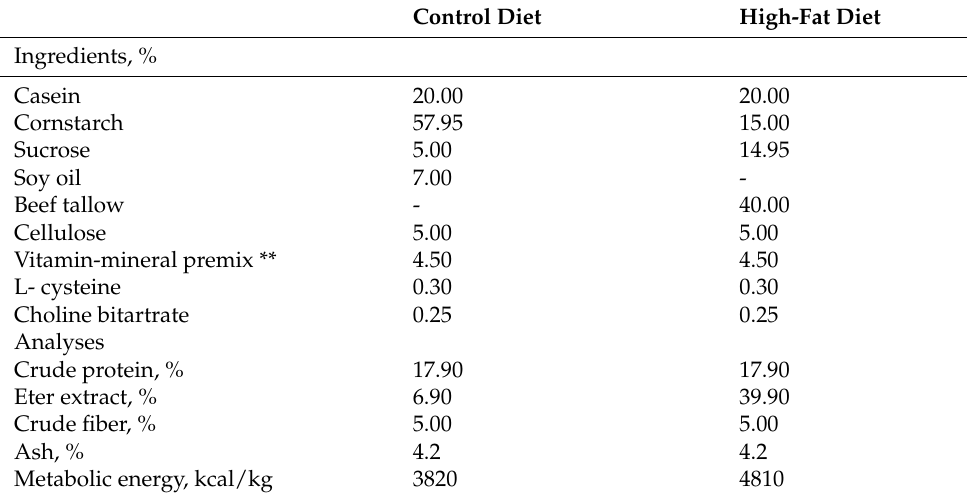
Table 1. Composition of experimental diets